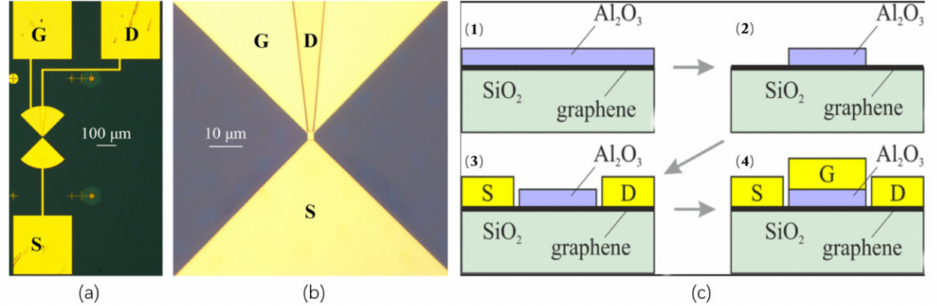
Figure 11. ( a , b ) The optical microscope image of the fabricated GFET detector (S, G, and D—source, gate, and drain, respectively) and the image of the GFET detector in the center of the antenna. ( c ) Schematic illustration of the fabrication steps of the graphene FET detector. (1) The graphene layer was covered by a thin Al seed layer and followed by natural oxidation; then, an Al 2 O 3 gate dielectric was grown on top of the seed layer by atomic layer deposition. (2) The Al2O3 was patterned and etched with a buffered oxide etch. (3) The source and drain contacts were fabricated by evaporating. (4) The gate electrode was evaporated and patterned on top of the patterned Al 2 O 3 layer. Reprinted with permission from ref. [135]. Copyright 2021 Copyright Clearance